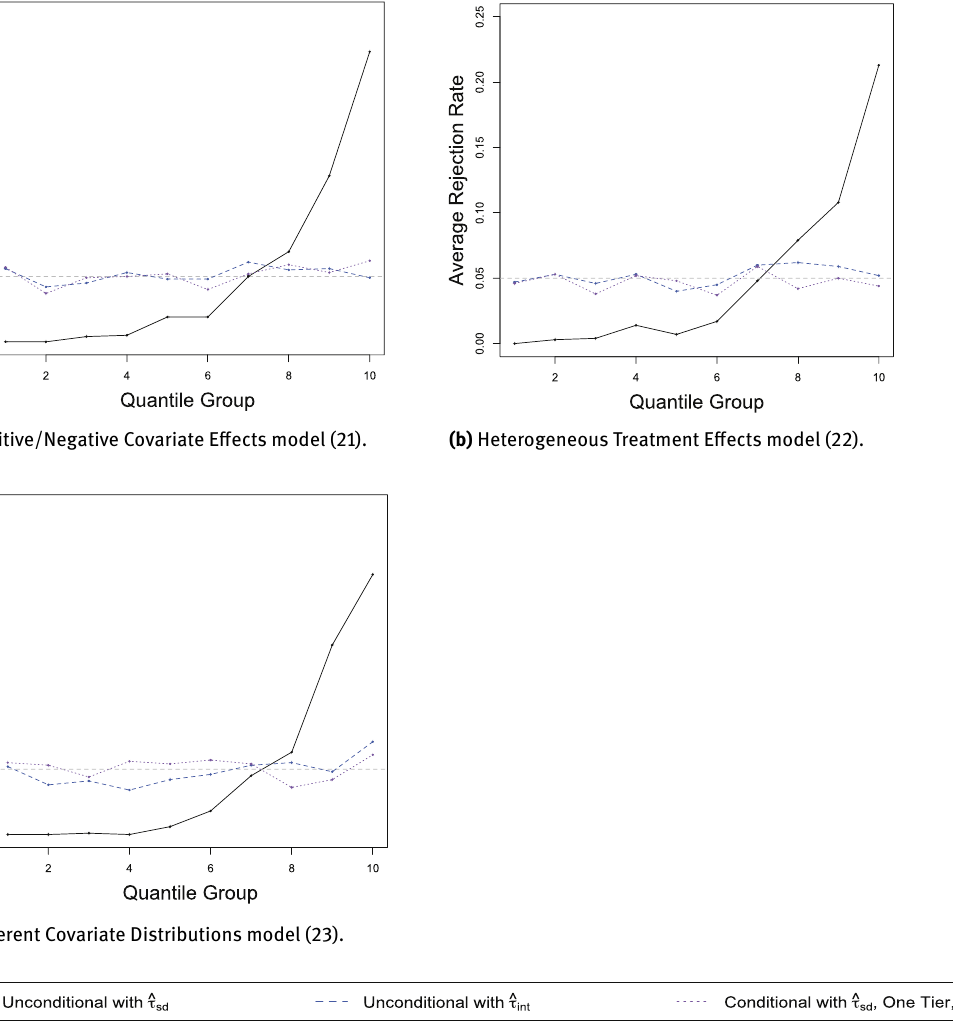
Figure 10: The rejection rate of the randomization tests within each quantile group of the Mahalanobis distance when the poten- tial outcomes were generated from the Positive/Negative Covariate Effects model (21), Heterogeneous Treatment Effects model (22), or Different Covariate Distributions model